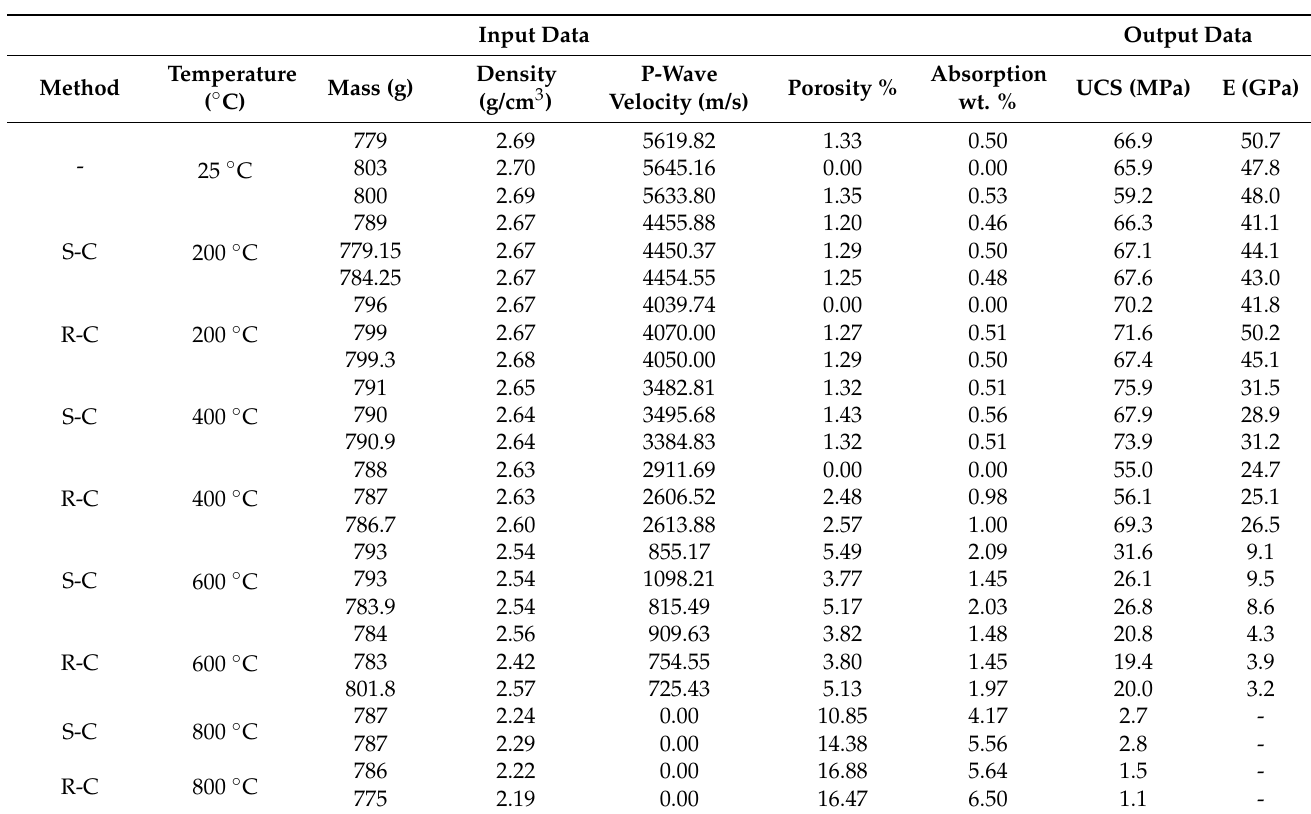
Table 2. Input and output data of prediction